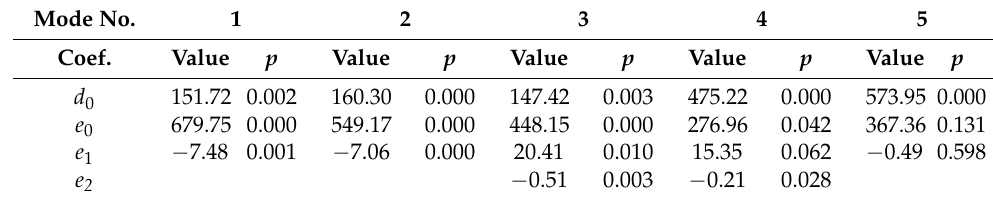
Table 6. Piecewise approximation coefficients of microhardness in the bimetal interface zone.